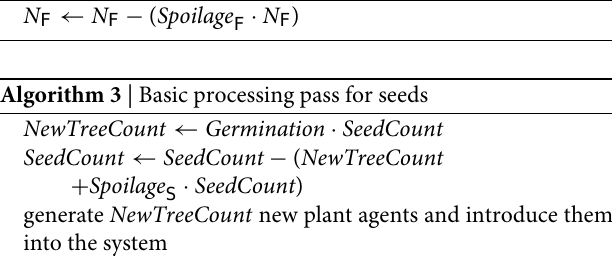
Algorithm 2 | Basic processing pass for fruit